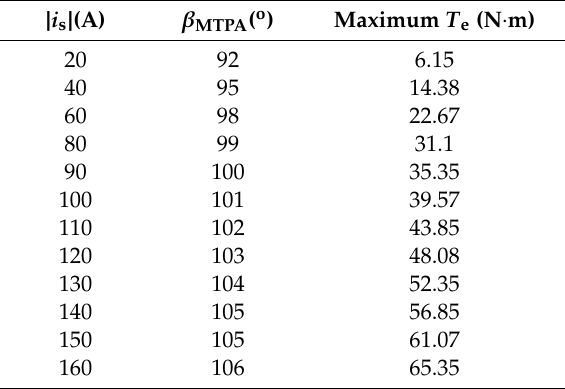
Table 2. The current vector angle under MTPA